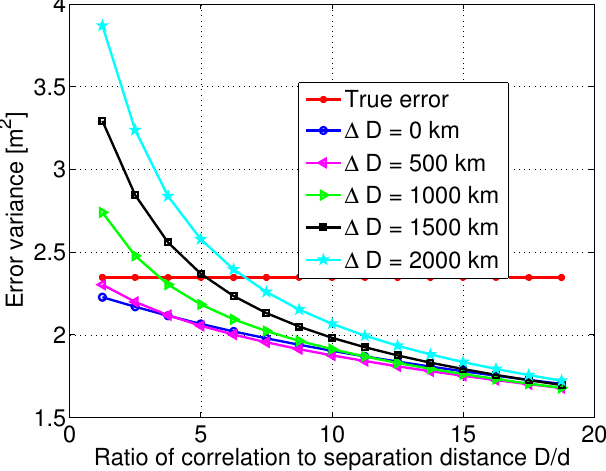
Figure 7. Estimation error variance corresponding to a single Gauss-Markov process and different ∆ D modeling errors.